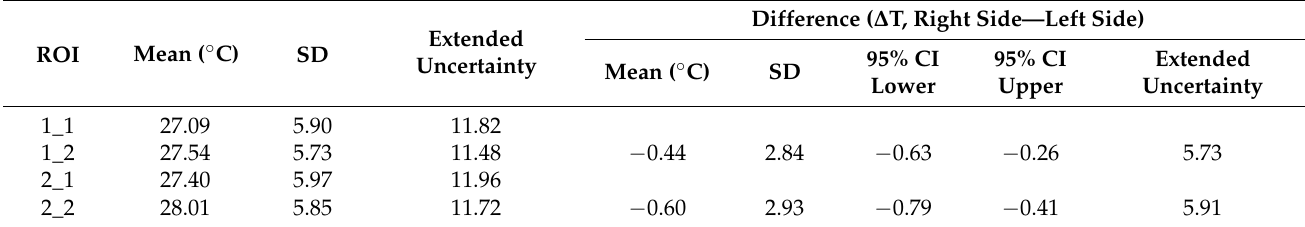
Table 3. Overall mean temperature of regions of interest in the lateral-side